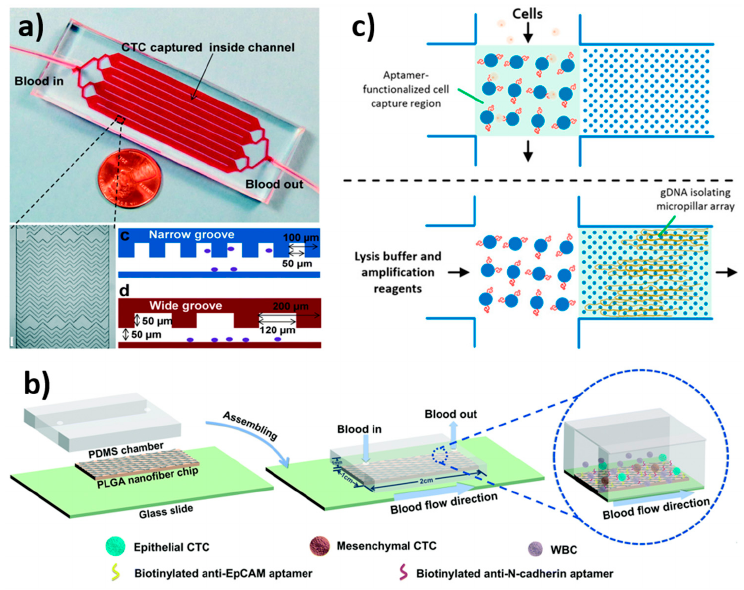
Figure 7. Schematic illustration of microfluidic devices for the isolation of CTCs using various techniques. ( a ) GEM chip with eight parallel channels with an inlet and an outlet showing asymmetric herringbone grooves inside the channel; reprinted with permission from ref. [163], 2013, Royal Society of Chemistry. ( b ) Schematic of dual aptamer-functionalised PLGA nanofiber-based microfluidic chip for the isolation of various phenotypic CTCs; reprinted with permission from ref. [164], 2021, Royal Society of Chemistry. ( c ) Schematic of microchannel design with aptamer- modified micropillar array for capturing cancer cells and isolating their gDNA; reprinted with permission from ref. [106], 2018, American Chemical Society. In addition, Jou et al. created the V-BioChip for isolating SKOV3 ovarian tumor cells from epithelial ovarian cancer patients’ blood samples [104]. Using anti-EpCAM antibody interactions on the device’s surface at a flow rate of 0.6 mL/h, the device demonstrated a capture efficiency of 48.3%. The combination of anti-EpCAM antibody and anti-N- cadherin antibody on the device surface resulted in a capture efficacy of 89.6%. Despite the functionalised surface, the obtained results showed a lower capture efficiency. Further, Wu et al. created a PLGA nanofiber, aptamer-functionalized microfluidic device for isolating ovarian cancer cells such as A2780 and OVCAR-3 cells [164] (Figure 7b). The EpCAM-functionalised chip demonstrated a good capture efficiency of 89% for OVCAR- 3 cells, while NC3S demonstrated high efficiency of 91% for A2780 with a release efficiency of 88% and 92%, respectively. Later, Reinholt et al. developed a PDMS microfluidic system to isolate HeLa (cervical cancer cell line) and CAOV-3 (ovarian cancer cell line) cancer cells [106] (Figure 7c). For the capture of CTCs via a streptavidin–biotin conjugation, the microchannel surface was functionalized with a DNA aptamer. The capture efficiency was great when the CTCs were suspended in PBS buffer and flushed into the microchannel at a flow rate of 5 μ L/min. The collected cells were also lysed using a DNA array channel. The cellular contents were allowed to flow out while the gDNA was isolated on the micropillar. The use of gDNA allows for the extraction of enormous amounts of data from a small number of cells without the need for genome amplification. In another study, Pulikkathodi et al. developed an AlGaN/GaN high-electron-mobility (HEMT) biosensor array for the detection and isolation of CTCs [165]. Furthermore, these chips are mounted on a thermos-curable polymeric substrate. The formed array has several aptamer-immobilized areas, which are sensitive to CTCs. The device showed high